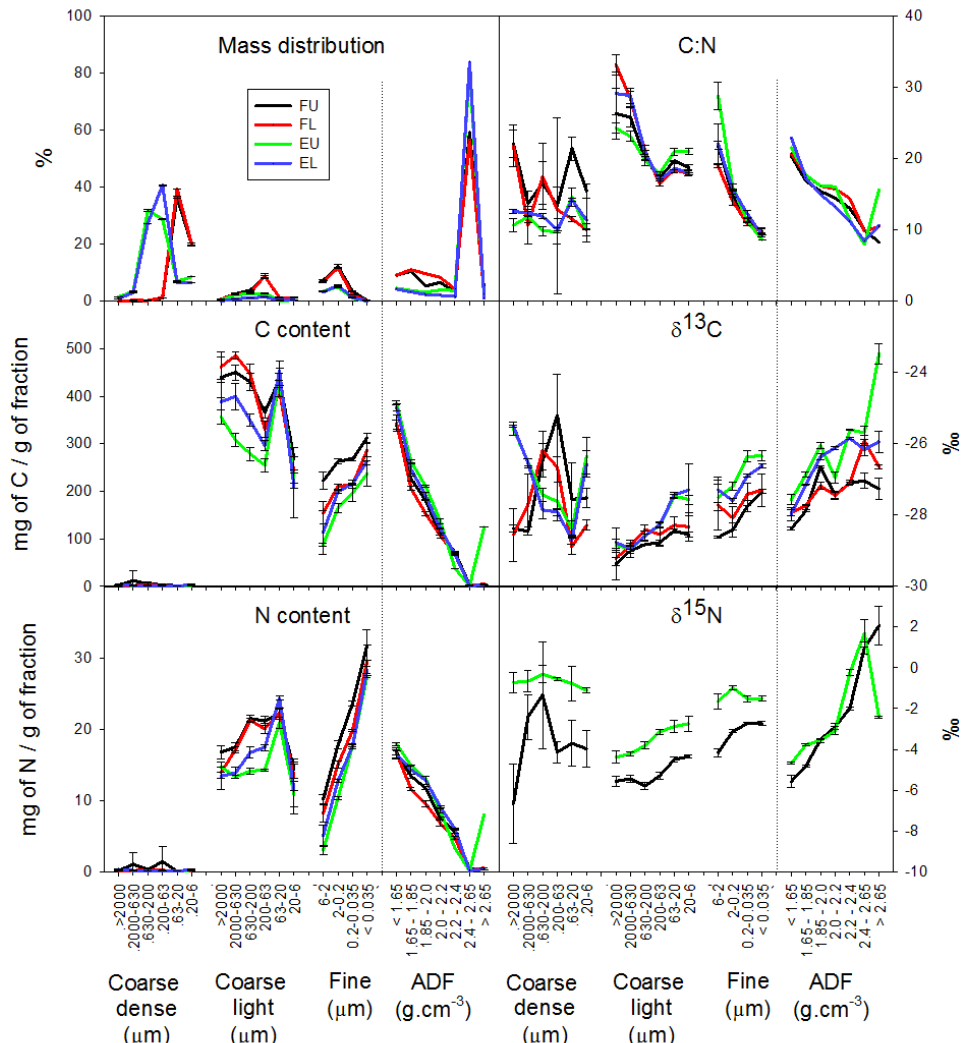
Fig. 3. Chemical characteristics of PSDF and ADF fractions isolated from Ebrach and Foug`eres labelled (El; FL) and unlabelled (EU; FU) soils. (Mass distribution, C and N contents, C/N ratio, as well as, δ 13 C and δ 15 N natural